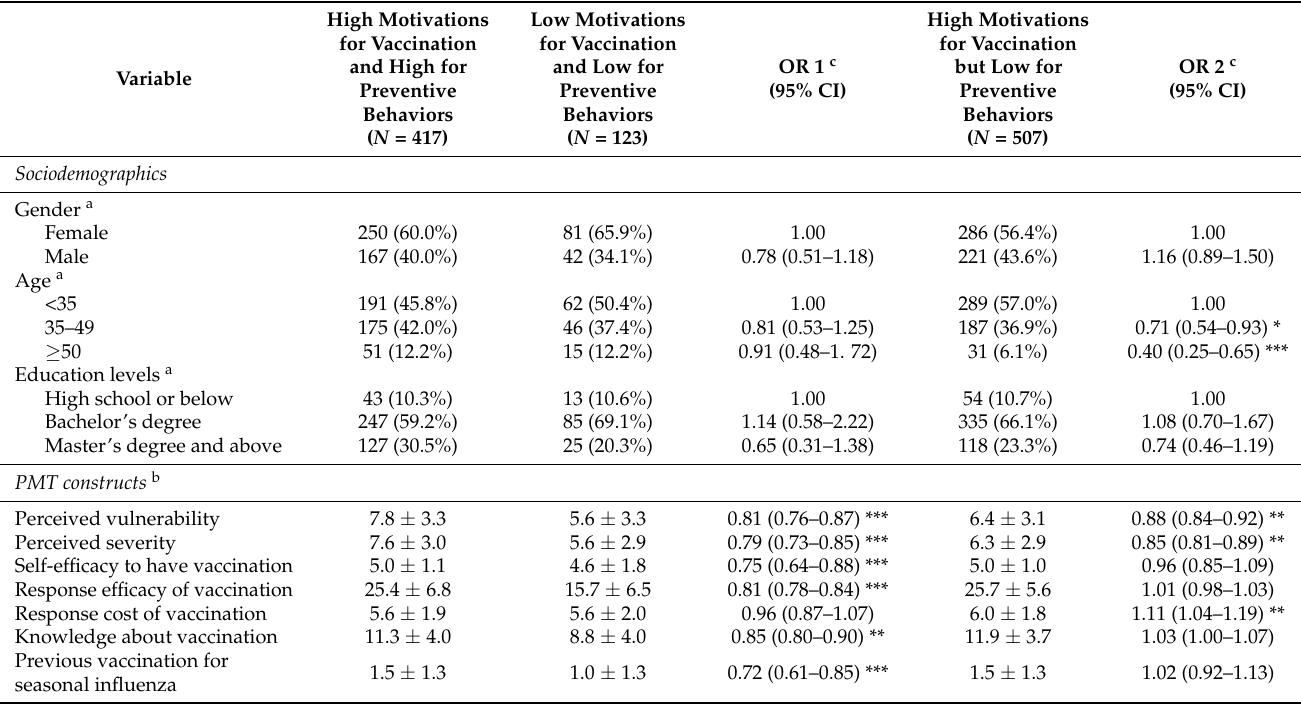
a Unadjusted multinomial logistic regression. b Multinomial logistic regression with the adjustment of sociodemographic characteristics. c The group with a high motivation to get vaccinated and to adopt preventive behaviors serves as the reference. CI: confidence